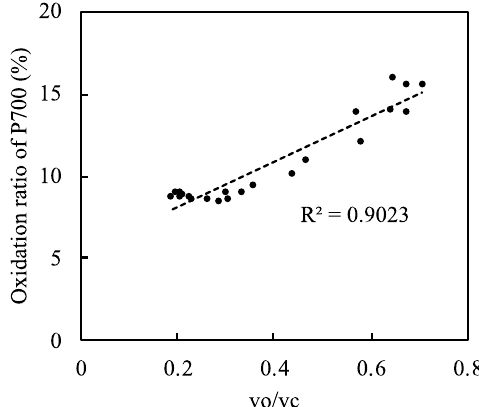
Figure 4. Relationship between the relative photorespiration activity (vo / vc) and the oxidation ratio of P700 in rice leaves. Both ribulose 1,5-bisphophate (RuBP) carboxylase reaction rate (vc) and RuBP oxygenase reaction rate (vo) were estimated by the method described in Materials and Methods. Data from Figures 2C and 3B were used. Dashed line in the graph was the regression line and the coefficient of determination was 0.9023 (p<0.001).